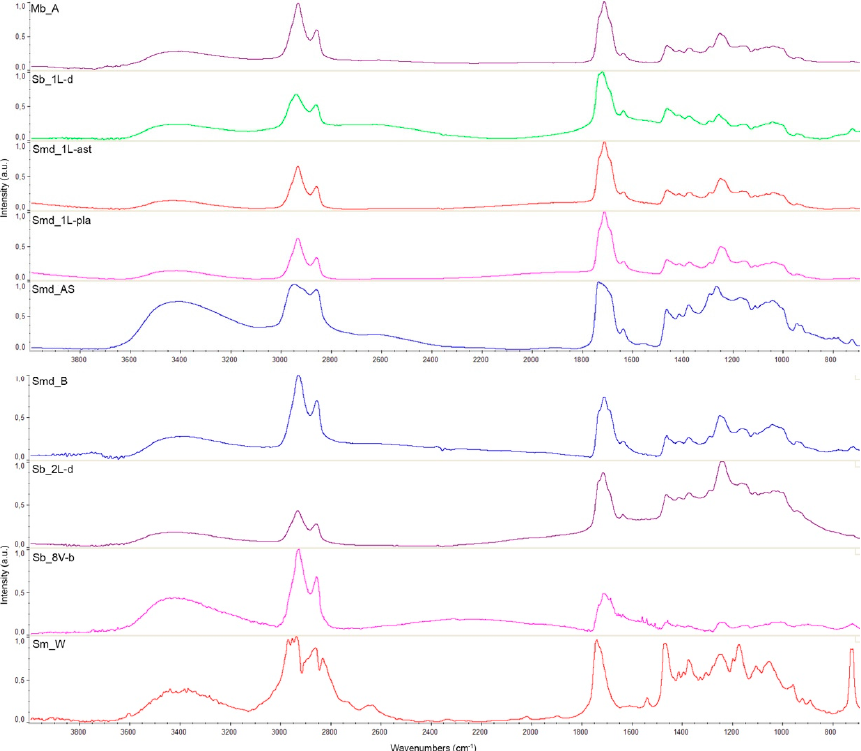
Figure 5. FTIR spectra of the representative samples for each varnish recipe and shellac wax. Spectrum Sb_8V-b was acquired with the benchtop instrument (cf. 2.3.3). Coatings 2021 , 11 , x FOR PEER REVIEW Figure 6 shows the FTIR spectra of samples before and after ageing. Spectra Sb_8V-a and Sb_8V-b were acquired with the benchtop instrument in order to obtain better spec- tral response (cf. 2.3.3).